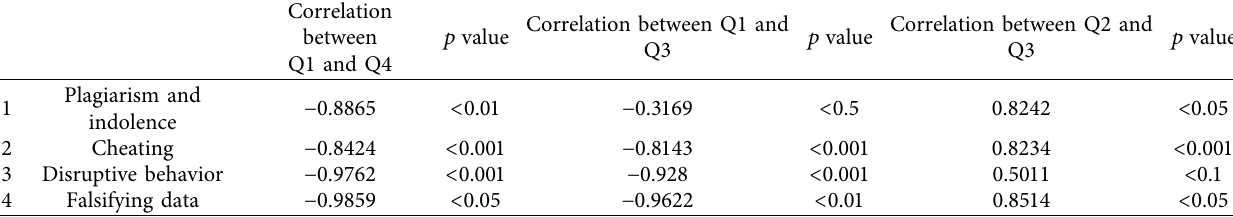
Table 2: Correlation between Q1 and Q4, Q1 and Q3, and Q2 and Q3.